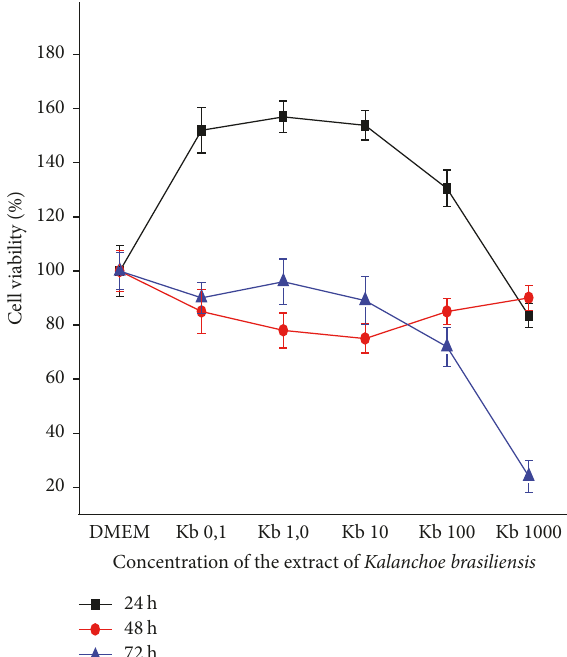
Figure 3: Viability of nontumoral cells (3T3) at periods of 24-, 48-, and 72-hour exposure to concentrations of 1–10 4 𝜇 L/mL of K. brasiliensis extract by the MTT method.